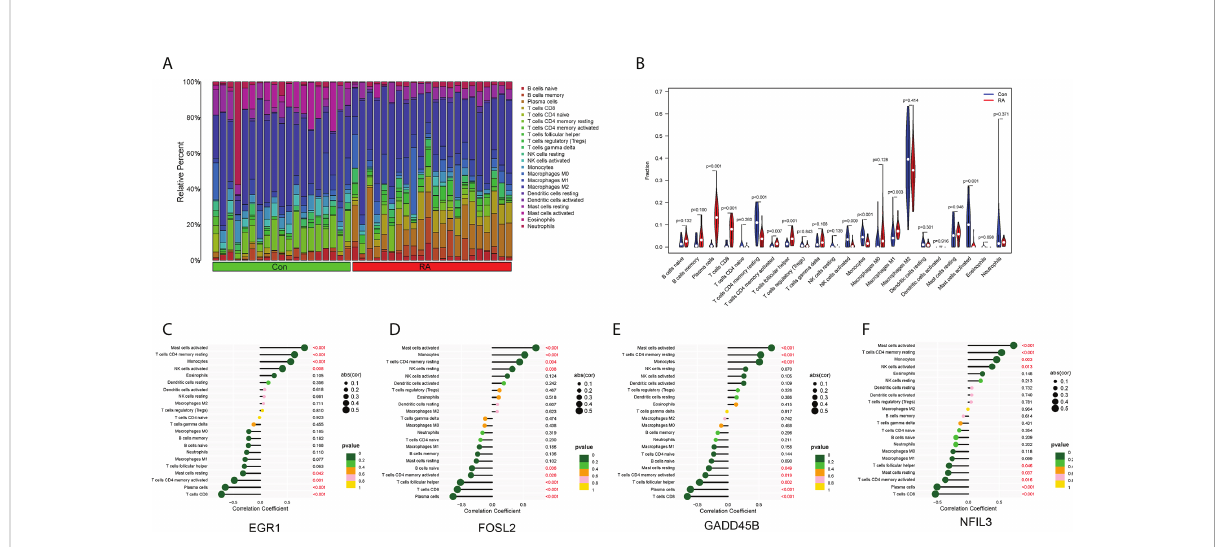
FIGURE 6 Immune cell in fi ltration. (A) Histogram showed the composition of 22 immune cells in each sample. (B) Violin plot showed the differences in in fi ltration levels of immune cells between RA and control groups. (C – F) Lollipop plots of the correlation between four hub CRGs and immune